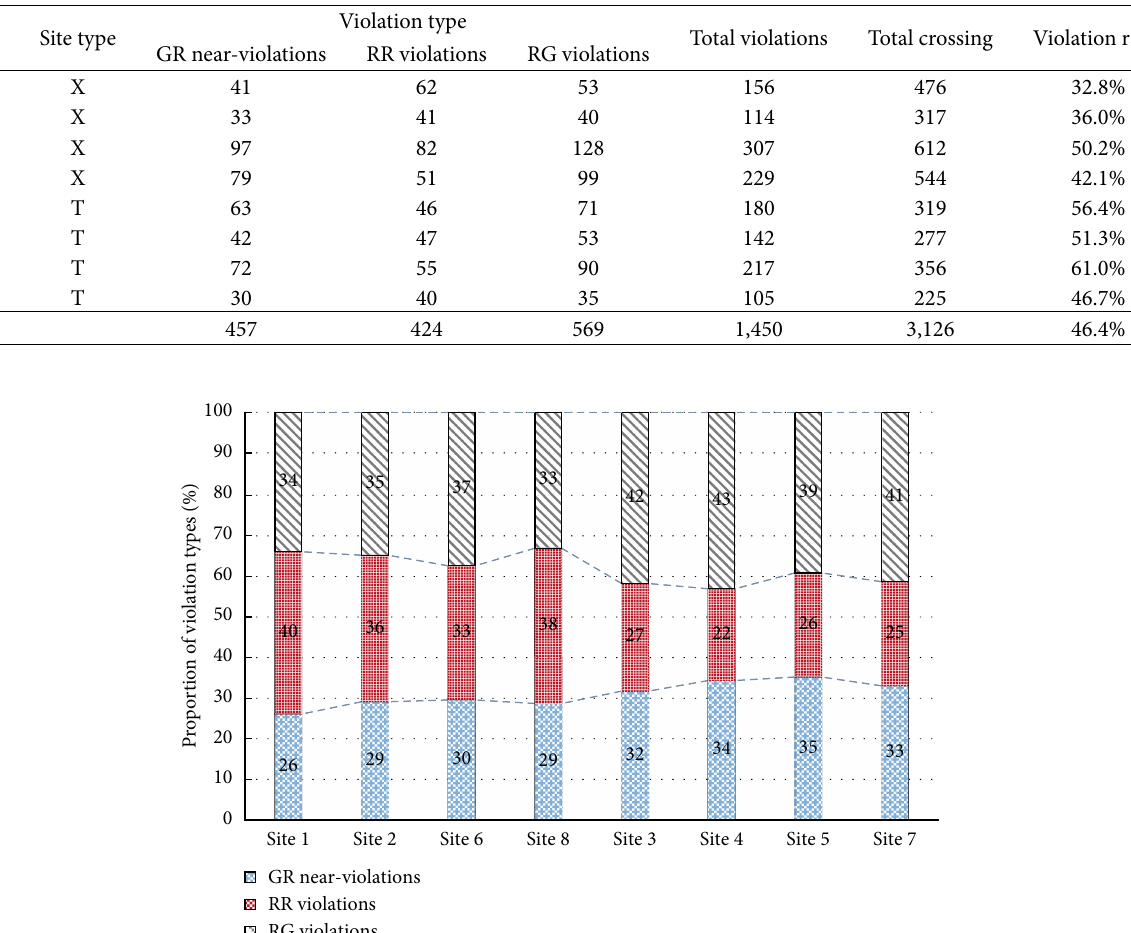
Table 5: Descriptive statistics of violations in study sites.